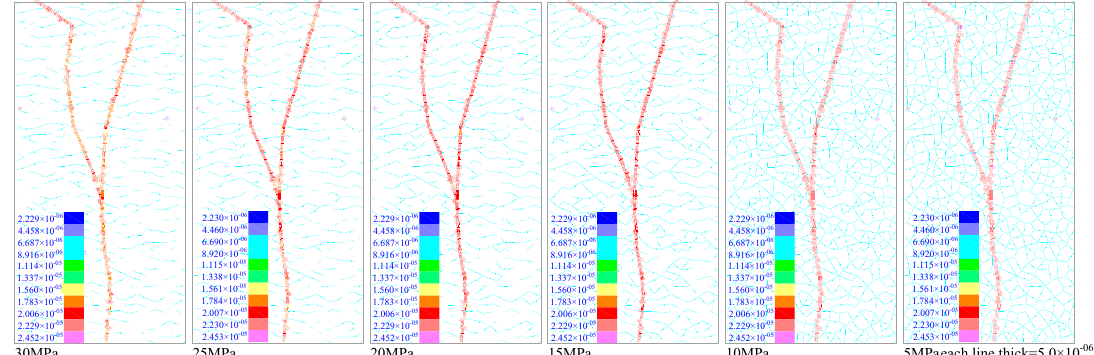
Appl. Sci. 2019 , 9 FOR PEER REVIEW